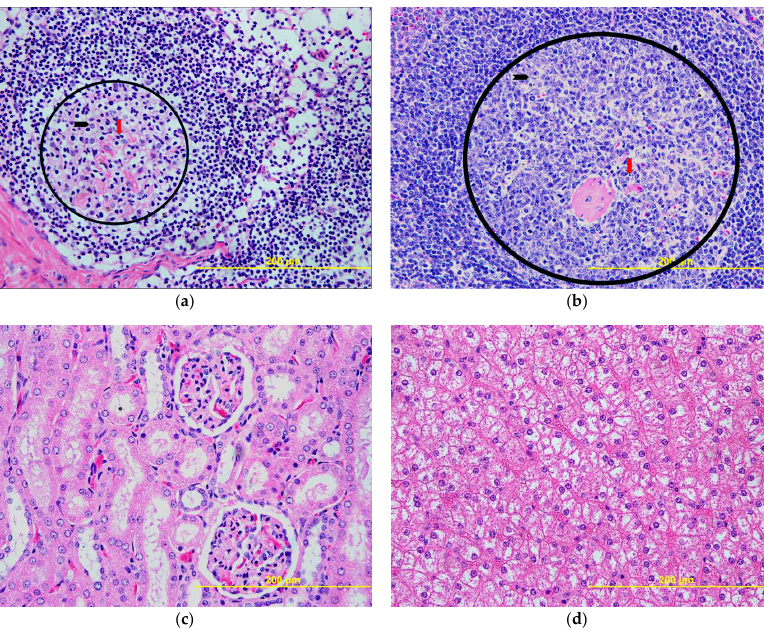
Lymph nodes, spleen, kidneys, liver, eyes, testicles, cerebral cortex, cerebellar cortex, spinal cord